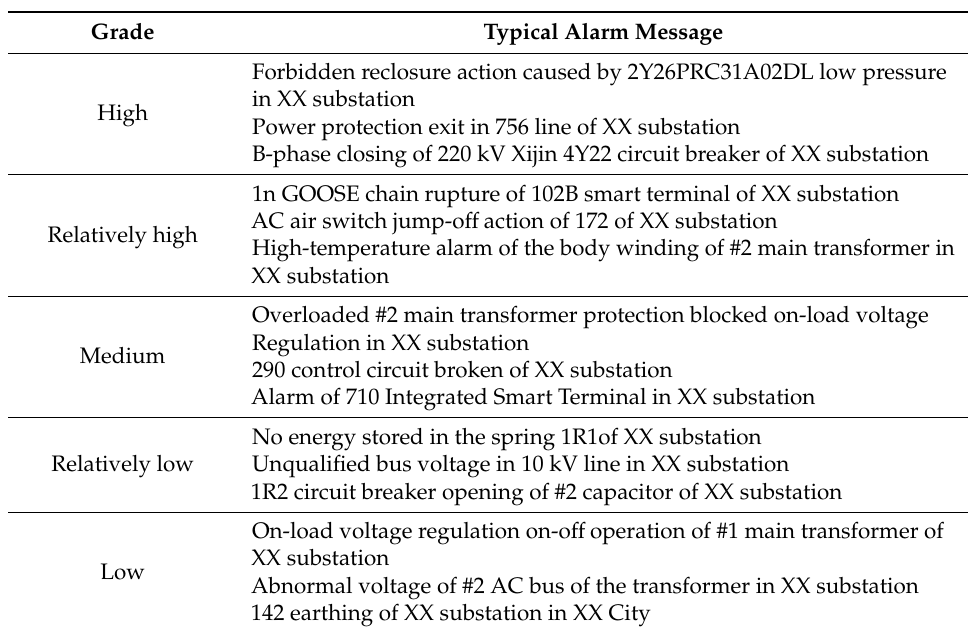
Table 6. Typical alarm messages for each classification grade.